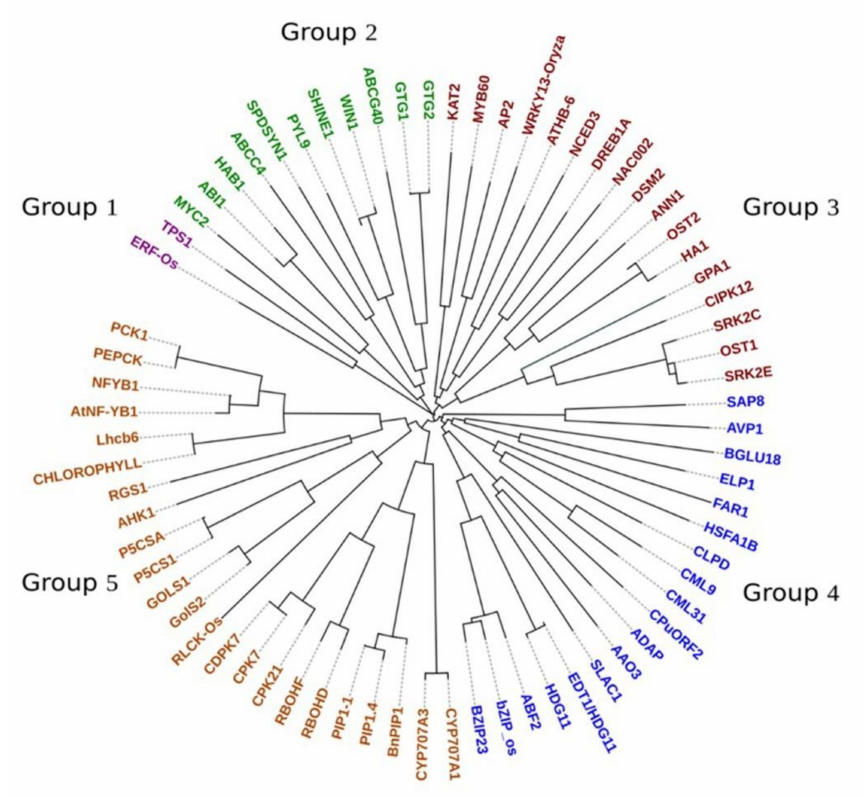
Figure 5. The phylogenetic tree of 74 drought genes in pearl millet grouped into five different